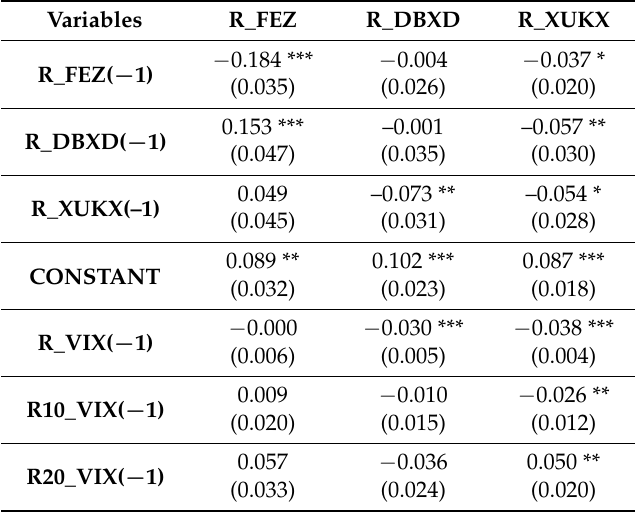
Table 14. Mean Equation for European Market ETF and VIX (After GFC) (1 April 2009 to 30 March 2015). Variables